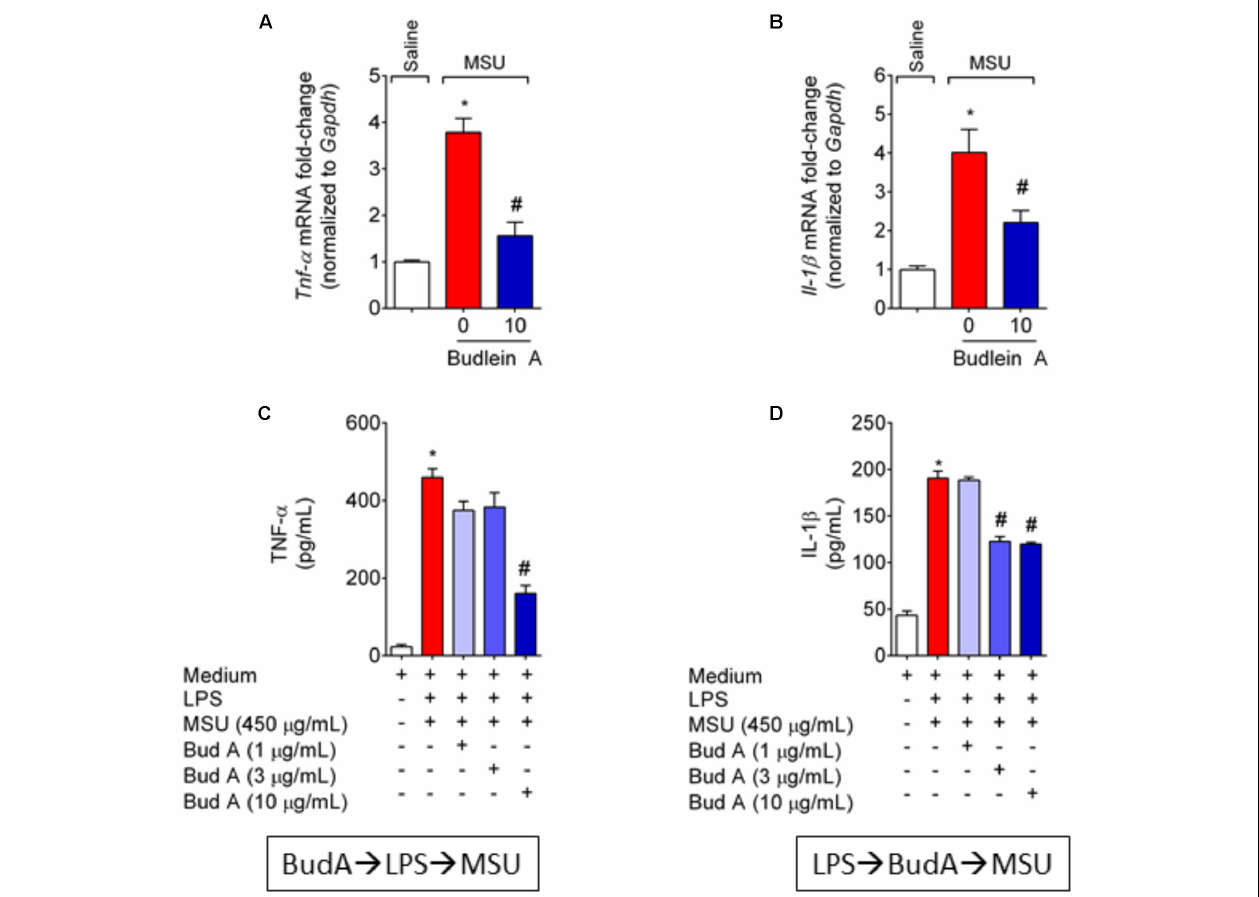
FIGURE 5 | Budlein A reduces in vivo and in vitro MSU-induced IL-1 β and TNF- α production. Fifteen hours after the injection of MSU crystals, knee joint was dissected for the determination of Tnf- α (A) and Il-1 β (B) mRNA expression by RT-qPCR. Results are expressed as mean ± SEM, n = 6 mice per group per experiment, two independent experiments. ∗ p < 0.05 vs. saline group; # p < 0.05 vs. 0 mg/kg group, one-way ANOVA followed by Tukey’s post hoc . For the in vitro assay, BMDMs were pre-treated with budlein A at 1, 3, or 10 µ g/mL 30 min before stimulus with LPS for the determination of TNF- α levels (C) by ELISA. For the determination of IL-1 β levels (D) by ELISA, LPS-primed BMDMs were treated with budlein A at 1, 3, or 10 µ g/mL 30 min after stimulus LPS. Supernatants were collected 5 h after MSU (C,D) . ∗ p < 0.05 vs. saline group; # p < 0.05 vs. 0 mg/kg group, one-way ANOVA followed by Tukey’s post hoc .